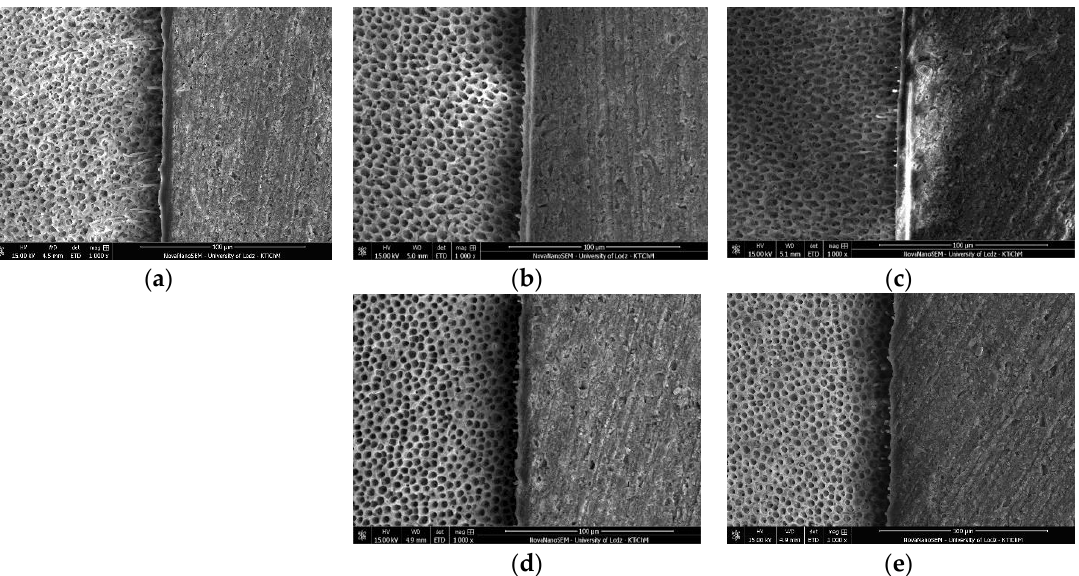
Figure 4. SEM micrographs of dentin specimens treated with Prime&Bond One Select: ( a ) 1A20 (control); ( b ) 2A20; ( c ) 3A20; ( d ) 2A40; ( e ) 3A60; mag. 1000 x.